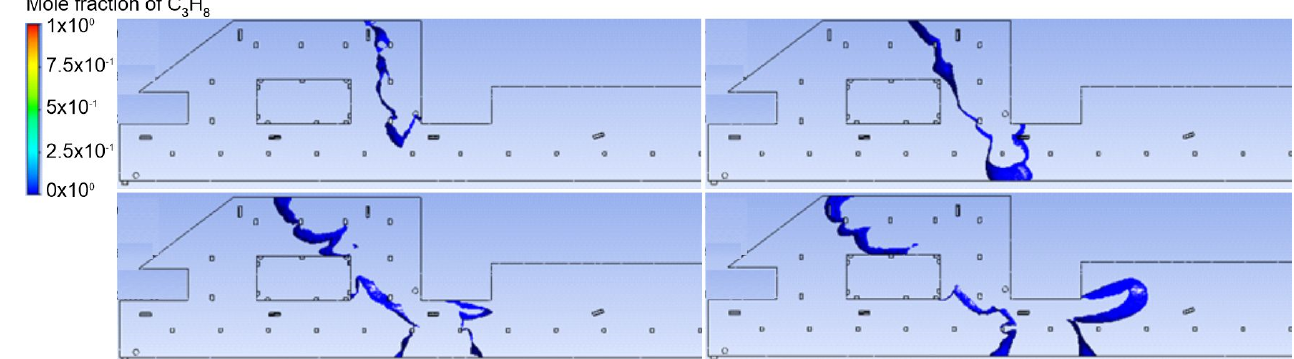
Figure 18. Trace amount of LPG near the end of dispersion for B source.